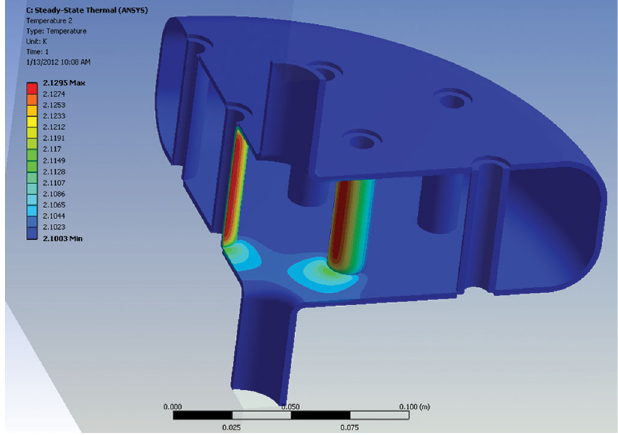
FIG. 11 (color online). Temperature distribution on the surface of a 2.1 GHz SRF PBG resonator with round rods immersed into superfluid liquid helium at 2 kelvin when operating CW at 10 MV = m accelerating gradient.